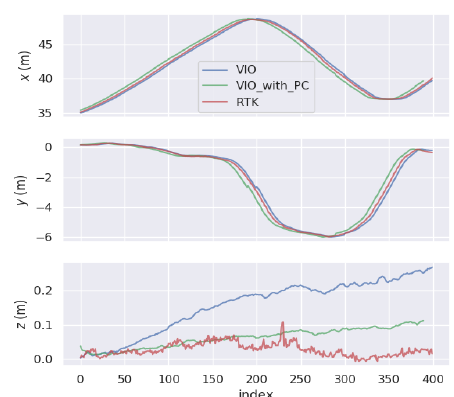
Figure 7. Components of three trajectories in coordinate axes.